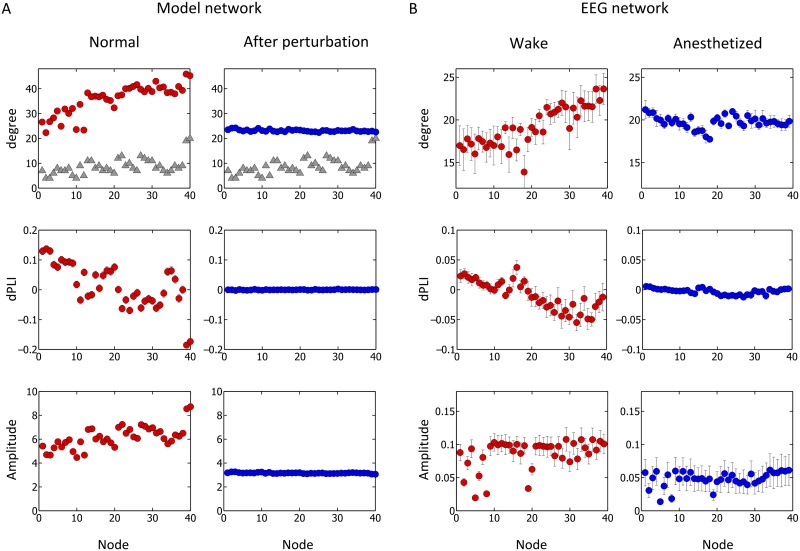
Comparison between model network and EEG network.Results were compared from the Stuart-Landau model on the human anatomical brain network of Gong et al. (A) and functional networks reconstructed from EEG (B). For each case, degree, average dPLI, and amplitude for each node is plotted with standard error, before and after perturbing the anatomic network for (A), and in wake (eyes closed) and anesthetized states for (B). In the graphs of the first row, the degree of nodes in red/blue circle is from PLI of the functional network constructed for each case. For the case of the model, (A), the degree of anatomical network is also shown in gray triangle for comparison. The nodes are aligned in a way that they are grouped by regions and span from frontal lobe to parietal lobe. For (A), nodes 1~22 are from frontal lobe, nodes 23~30 are from central regions (motor and somatosensory cortex), and nodes 31~40 are from parietal lobe. For (B), nodes 1~18 are from frontal lobe, nodes 19~29 are from central regions, and nodes 31~39 are from parietal lobe. For the simulation, time delay between each node was given proportional to the delay, with propagation speed of 6m/s. The coupling strength S was given as 1.5.